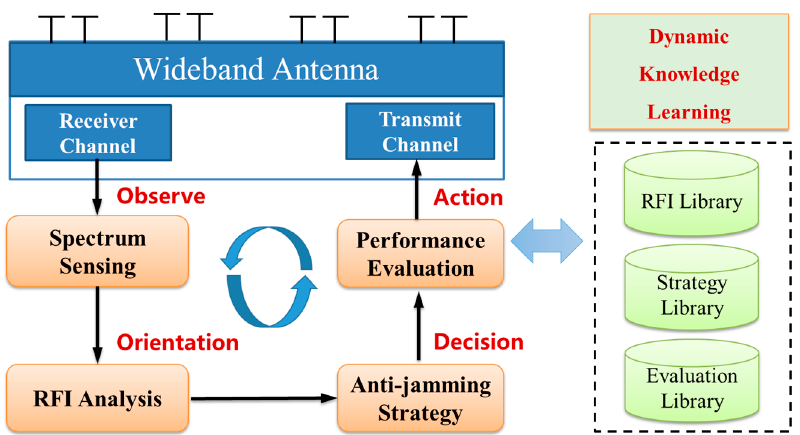
Figure 11. Illustration of system architecture for future SAR systems incorporated with RFI mitigation